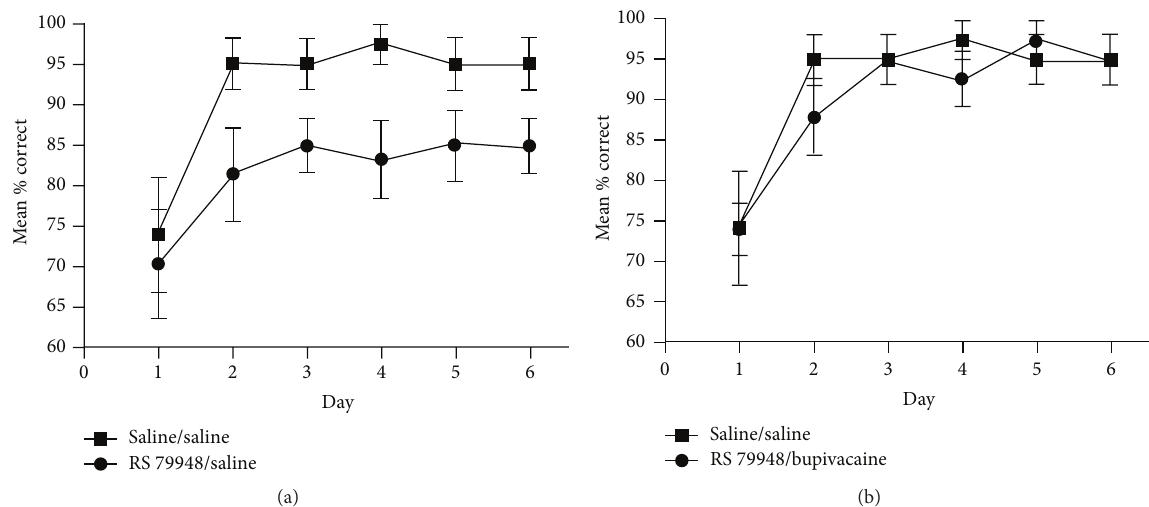
Figure 10: (a) Posttraining peripheral injections of RS 7948 impair cognitive memory, but (b) BLA inactivation with bupivacaine blocks this impairment